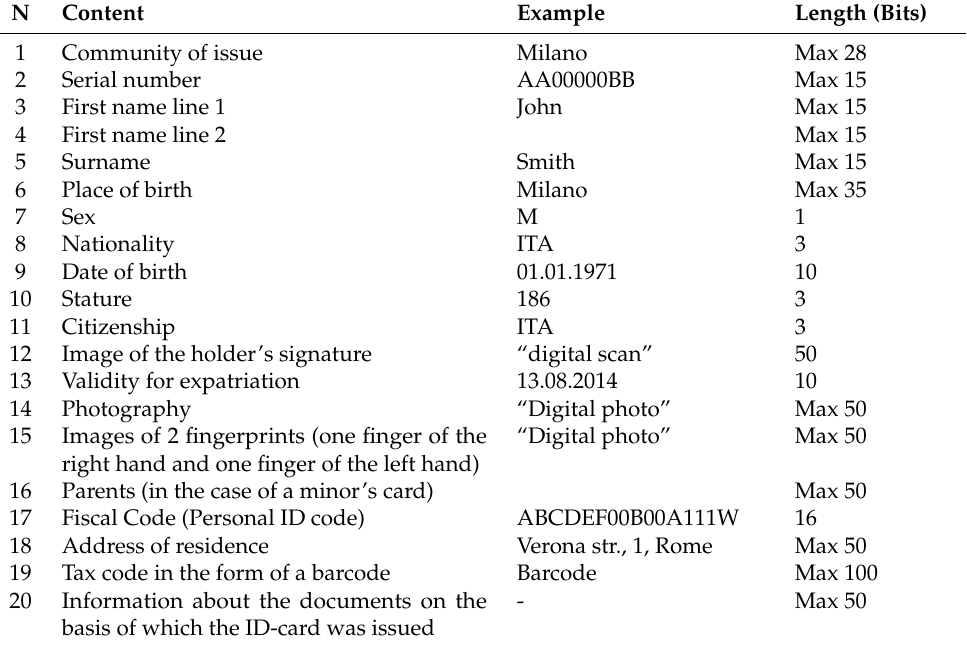
Table 2. Contents of personal data stored on an